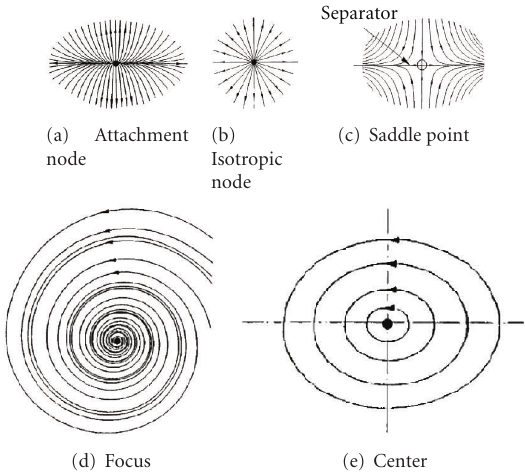
modeling of corners as sharp edges instead of smooth